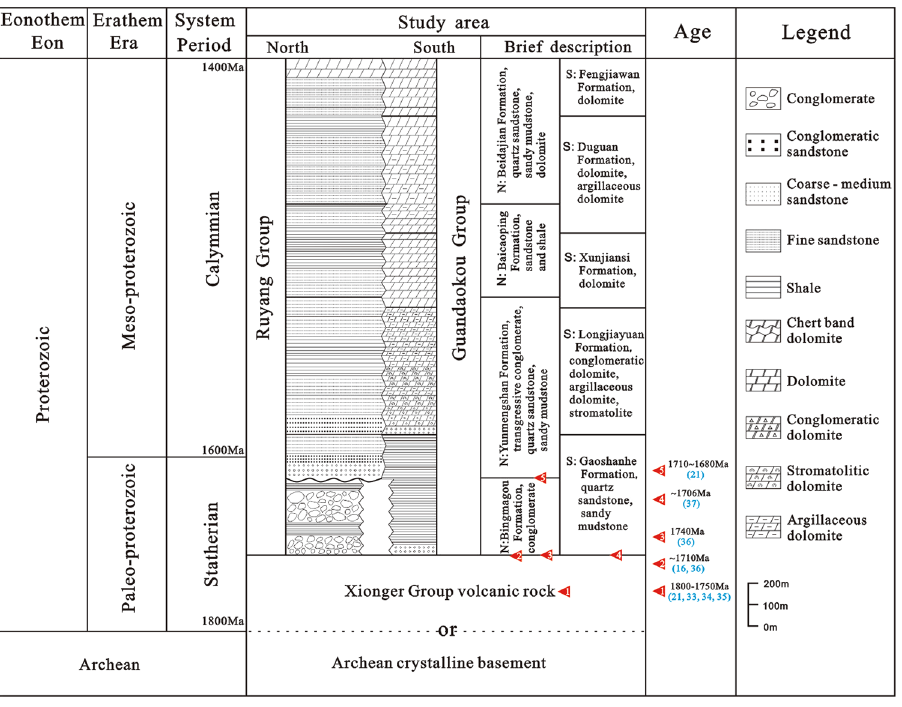
Figure 2. Regional stratigraphic column of the study area (21) 59,62–65